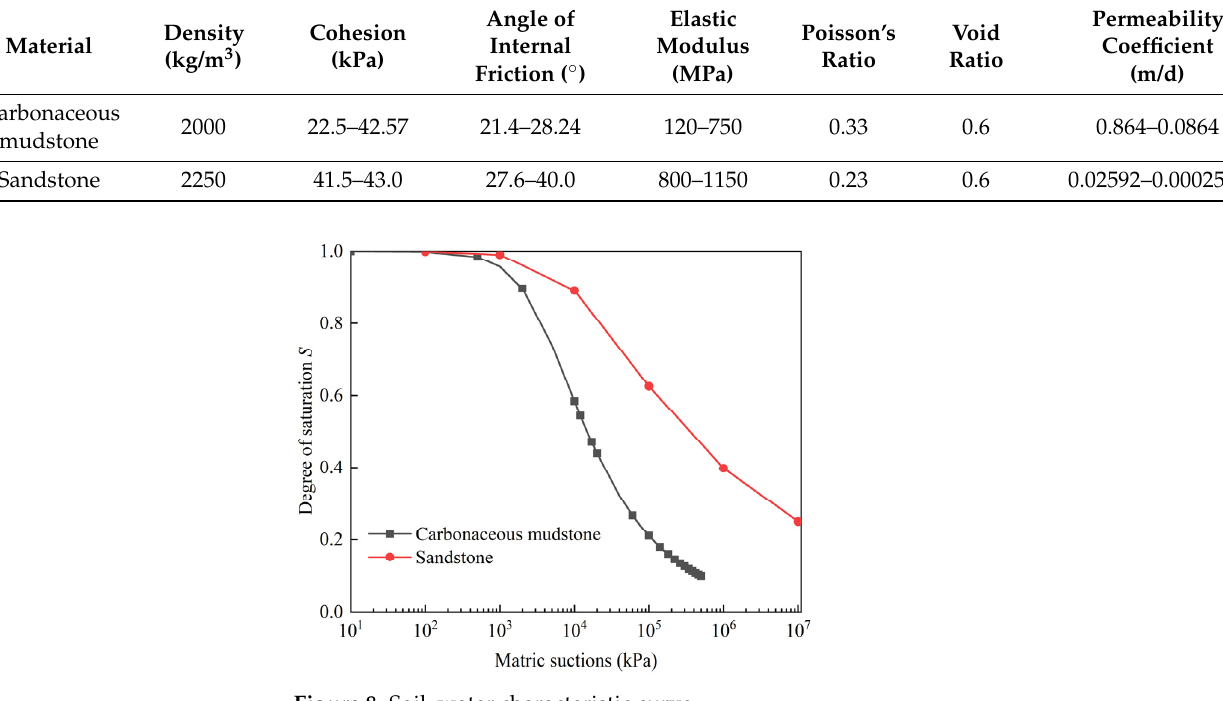
Figure 8. Soil–water characteristic